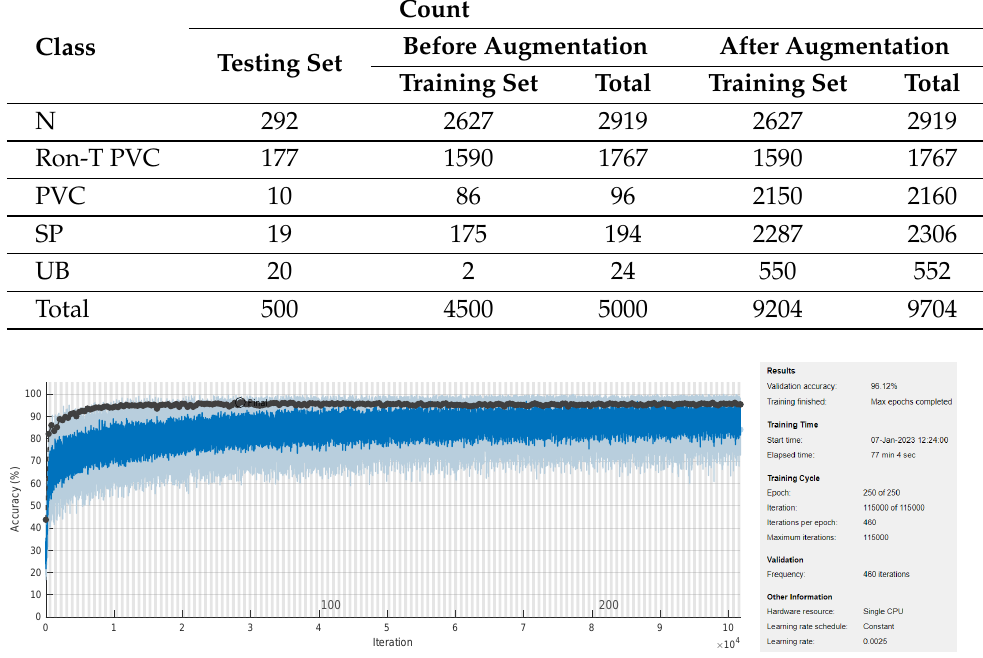
Figure 6. Training and validation process of TCN model in Experiment 1 of Table